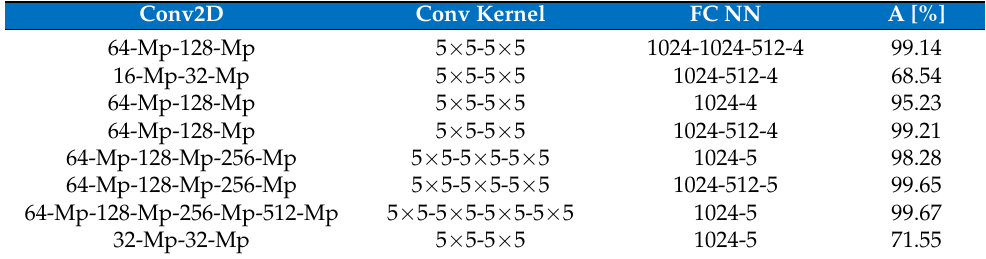
Table 1. Comparison of PD pattern classification performance by CNN in monitoring aging